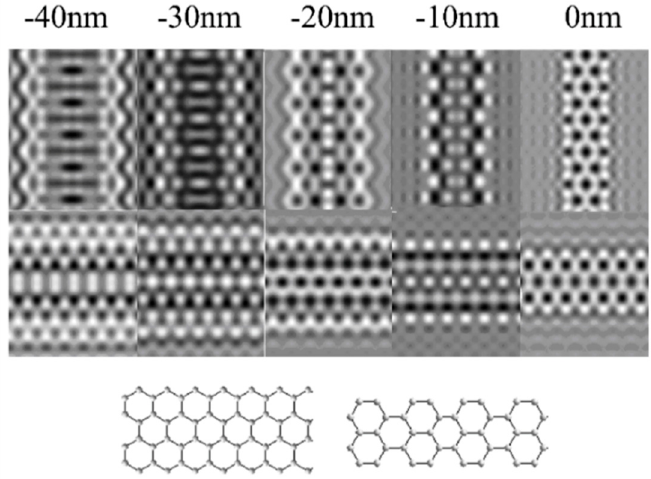
Figure 35. Computer simulation of HRTEM contrast showing zigzag and armchair ribbons of monolayer graphene layers (reprinted with permission from [210]).